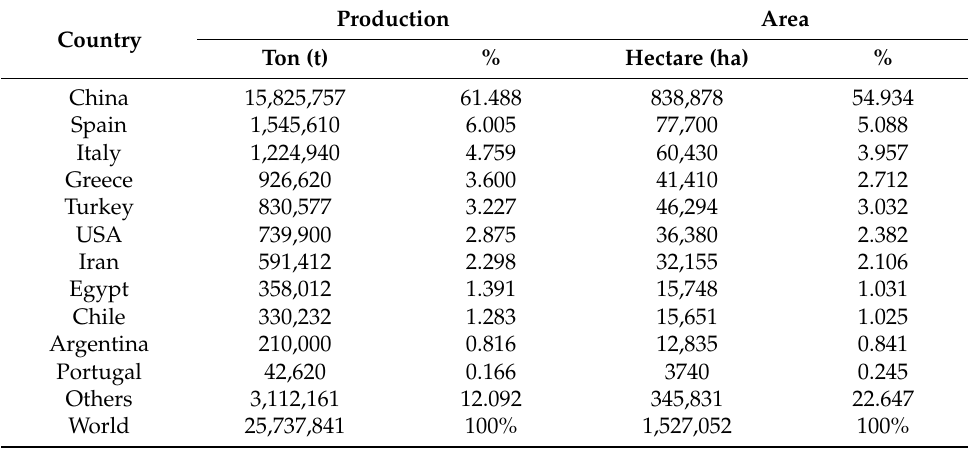
Table 1. Main peach and nectarine producing countries